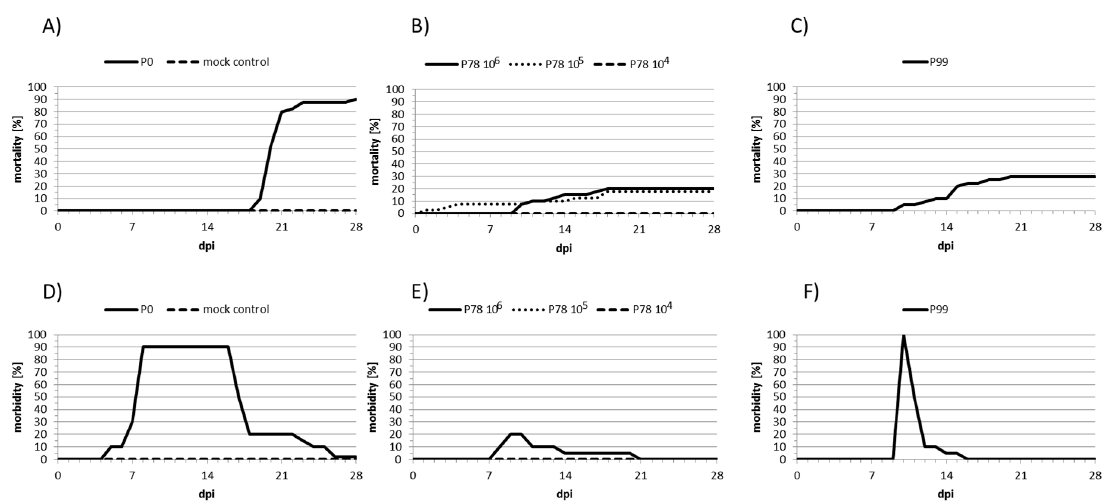
Figure 1. Mortality and morbidity, elicited by the three forms of KHV-T. Carp were experimentally infected with P0 and P99 at a dose of 10 5 TCID 50 / mL, and with P78 at doses of 10 4 TCID 50 / mL, 10 5 TCID 50 / mL and 10 6 TCID 50 / mL. Mortality ( A – C ) and morbidity ( D – F ) were recorded during 28 days post-infection (dpi) and plotted at scale.